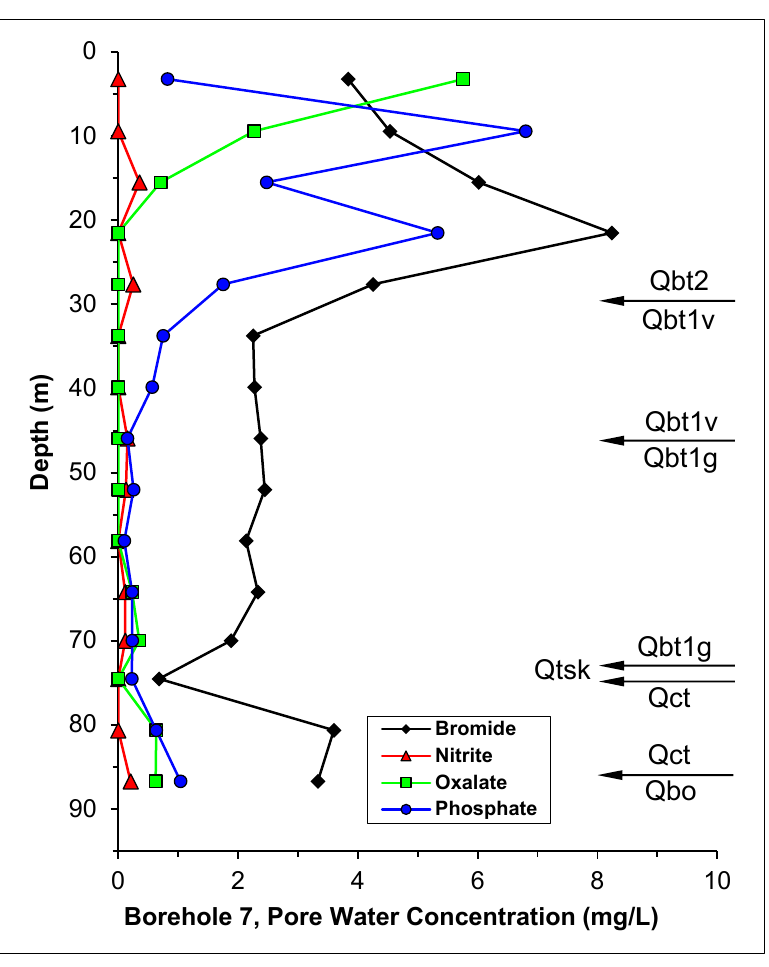
Figure 5. Pore water bromide, nitrite, oxalate, and phosphate concentrations in Borehole 7, TA ‐ 53. Stratigraphic contacts are shown on the right side of the figure.